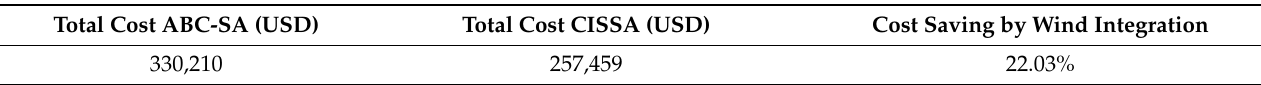
Table 37. Total cost comparison between CISSA and